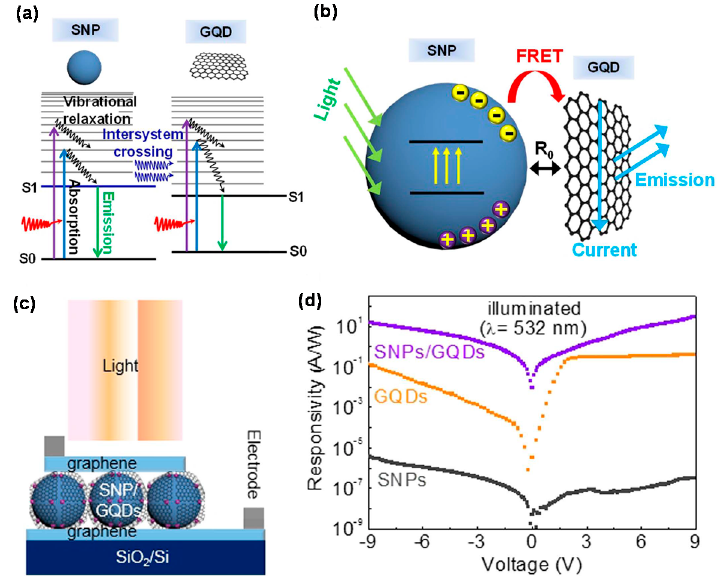
Figure 11. ( a ) Band structures of silica NPs (SNP) and graphene QD (GQD). Possible absorption/emission/transfer processes are described. Here, S0 and S1 indicate ground and lowest excited states, respectively. SNPs are highly absorptive, especially in the range of the emission spectrum of GQDs; ( b ) A schematic of a typical Förster resonance energy transfer (FRET) system composed of SNPs and GQDs as donors and acceptors, respectively. Photo-excited electron-hole pairs occupy mostly surface states of SNPs, thereby making it easy for the energy to be transferred to adjacent GQDs. The distance at which the FRET efficiency drops to 50% is defined as the Forster radius ( R 0 ), typically in the range of 1–10 nm. The use of one-atom-thick GQDs for acceptors can minimize R 0 and maximize the contacting area of the acceptors and the donors; ( c ) Schematic of the PD structure composed of the FRET system sandwiched between single-layer graphene sheets; ( d ) Responsivities of SNPs, GQDs, and SNPs/GQDs hybrid as functions of bias voltage, excited at 532 nm. Reproduced with permission for Figure 11a–d from 2016 Scientific Reports [86].